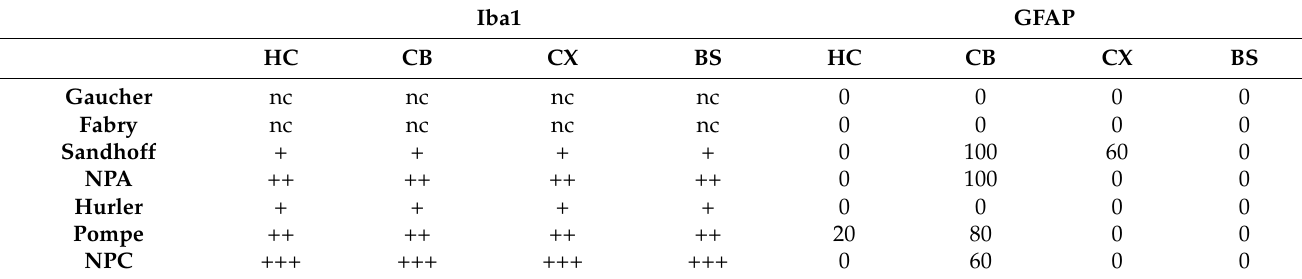
Table 3. Microglial activation and astrocytic GFAP expression in brains of LSD model mice. Iba1